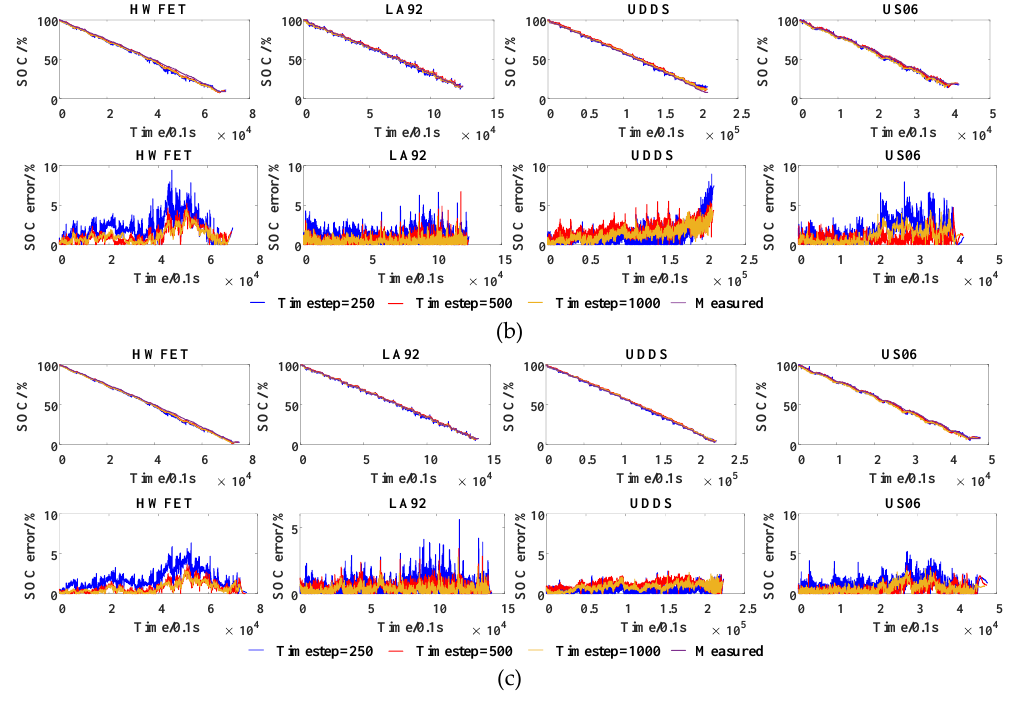
Figure 9. SOC estimation curves with different values of timestep: ( a ) 0 °C; ( b ) 10 °C; ( c ) 25 °C. Table 3. SOC estimation results with different values of timestep.